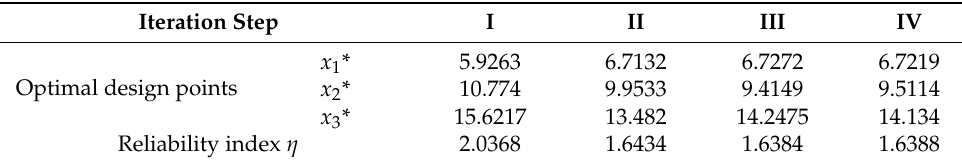
Table 3. Iterative process for solving Example 2.